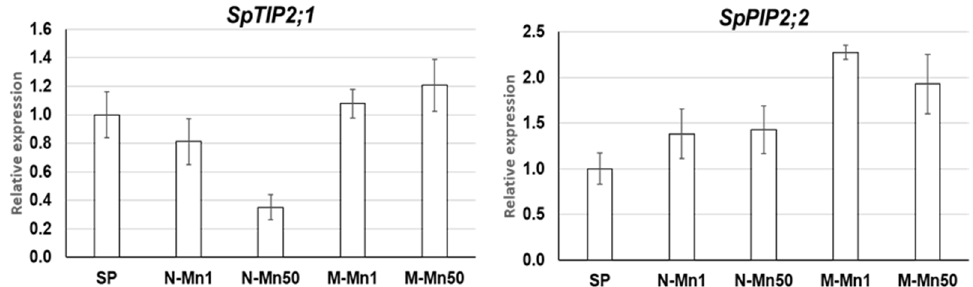
Figure 7. Expression patterns of two aquaporin genes, SpTIP2;1 and SpPIP2;2 , in duckweed cultivated in different media (N-Mn1, M-Mn1, N-Mn50 and M-Mn50). The genes expression was estimated at the cultivation day 4 by RT-qPCR relating to day 0, starting point (SP). Gene expression levels are in relative units. Error bars show ± SD of 3 replicates ( p < 0.05).